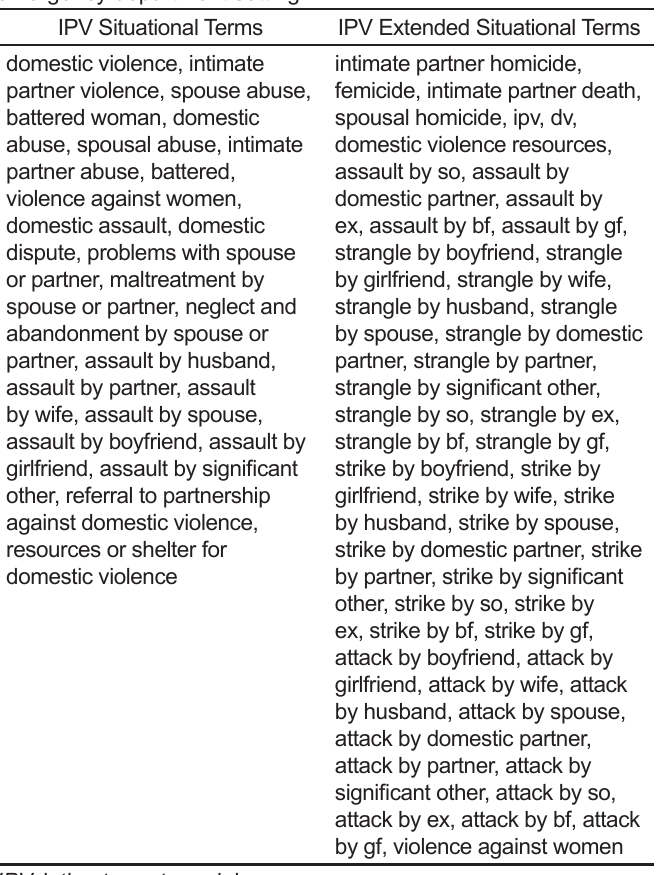
Table 2. Intimate partner violence (IPV) situational terms and IPV extended situational terms to identify positive IPV cases in an emergency department setting.